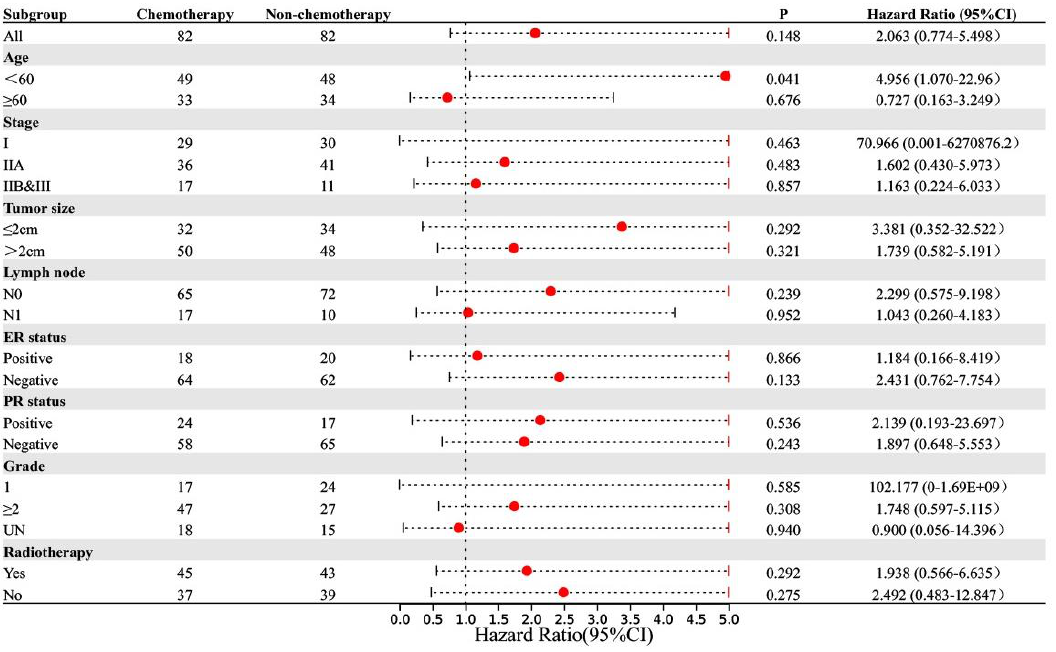
Figure 4. Subgroup analysis of BCSS in chemotherapy and non-chemotherapy groups .